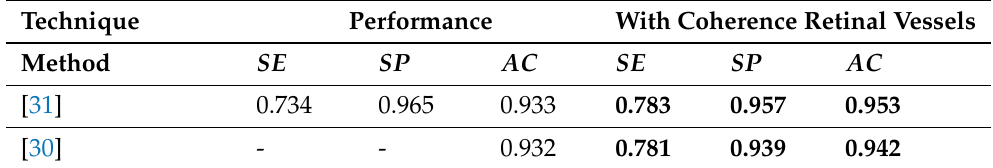
Table 4. The Impact of a Post-processing Module on Previous Techniques: DSTARE Dataset.